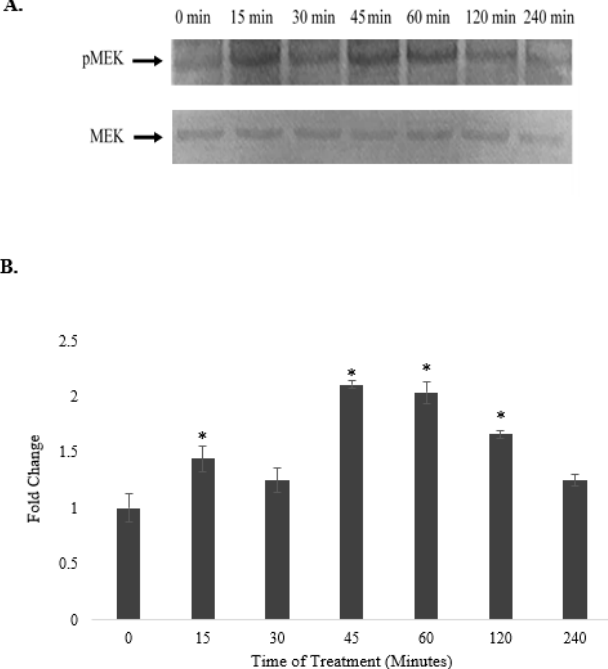
Figure 8. Time-course study on the effects of A. planci on the phosphorylation of MAPK. HepG2 cells were either untreated or treated with 6.25 µg/mL of selected A. planci fraction over a period of 4 h. Isolated cytoplasmic extracts were subjected to Western blot analysis using antibodies against total and phospho-MAPK ( A ). The levels of protein expression for phospho-MAPK were normalized against those for total MAPK, and the value at each time point represents the fold change of normalized phospho-MAPK protein expression relative to the untreated control, which was assigned a value of 1. * indicates that the value at a particular time point was significantly higher than that of the untreated control ( B ).